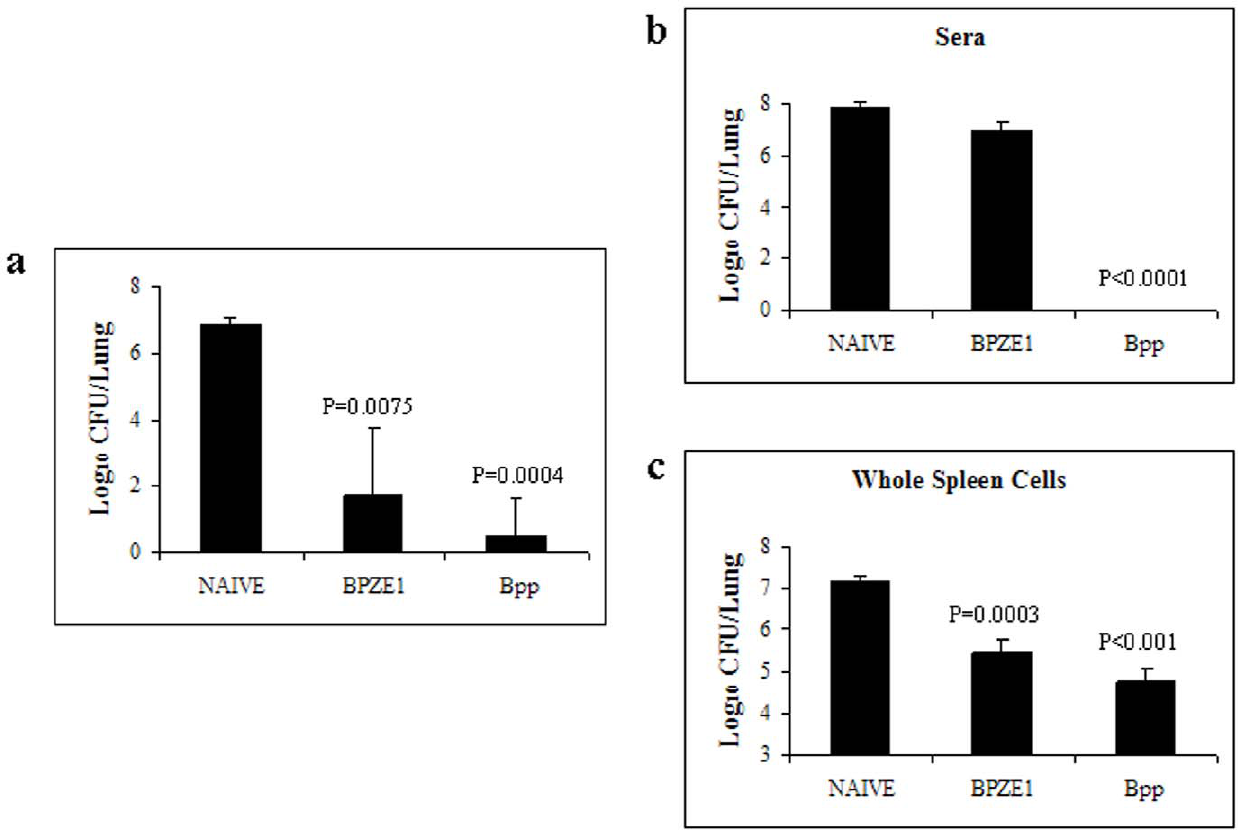
Figure 7. BPZE1-induced immunity cross-protects against Bordetellaparapertussis . BALB/c mice were intranasally infected with 1 6 10 6 CFU of B. pertussis BPZE1 (BPZE1) or B. parapertussis (Bpp) or left untreated (Naı¨ve). The mice were then challenged 8 weeks later with 1 6 10 6 CFU B. parapertussis and sacrificed 7 days after challenge for counting of CFUs in the lungs ( a ). 100 m l of sera ( b ) or 50 6 10 6 whole spleen cells ( c ) from BPZE1-immunized, B. parapertussis -infected or naı¨ve mice were injected intraperitoneally into naive SCID mice. 24 h later, the mice were intranasally infected with B. parapertussis and sacrificed seven days later for CFU counts in the lungs. The results are expressed as means of log CFU values per lung from 5 mice per group ( 6 standard error) and are representative of three independent experiments.